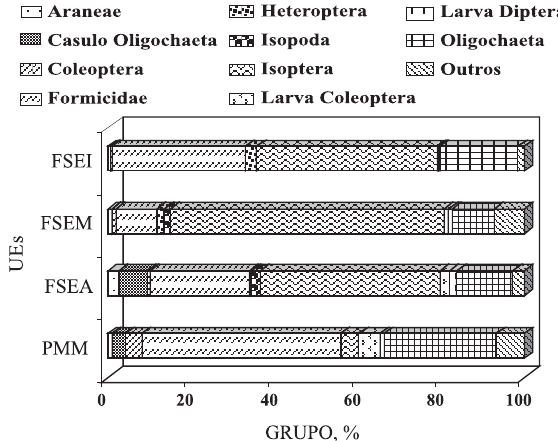
Figura 4. Distribuição da macrofauna edáfica